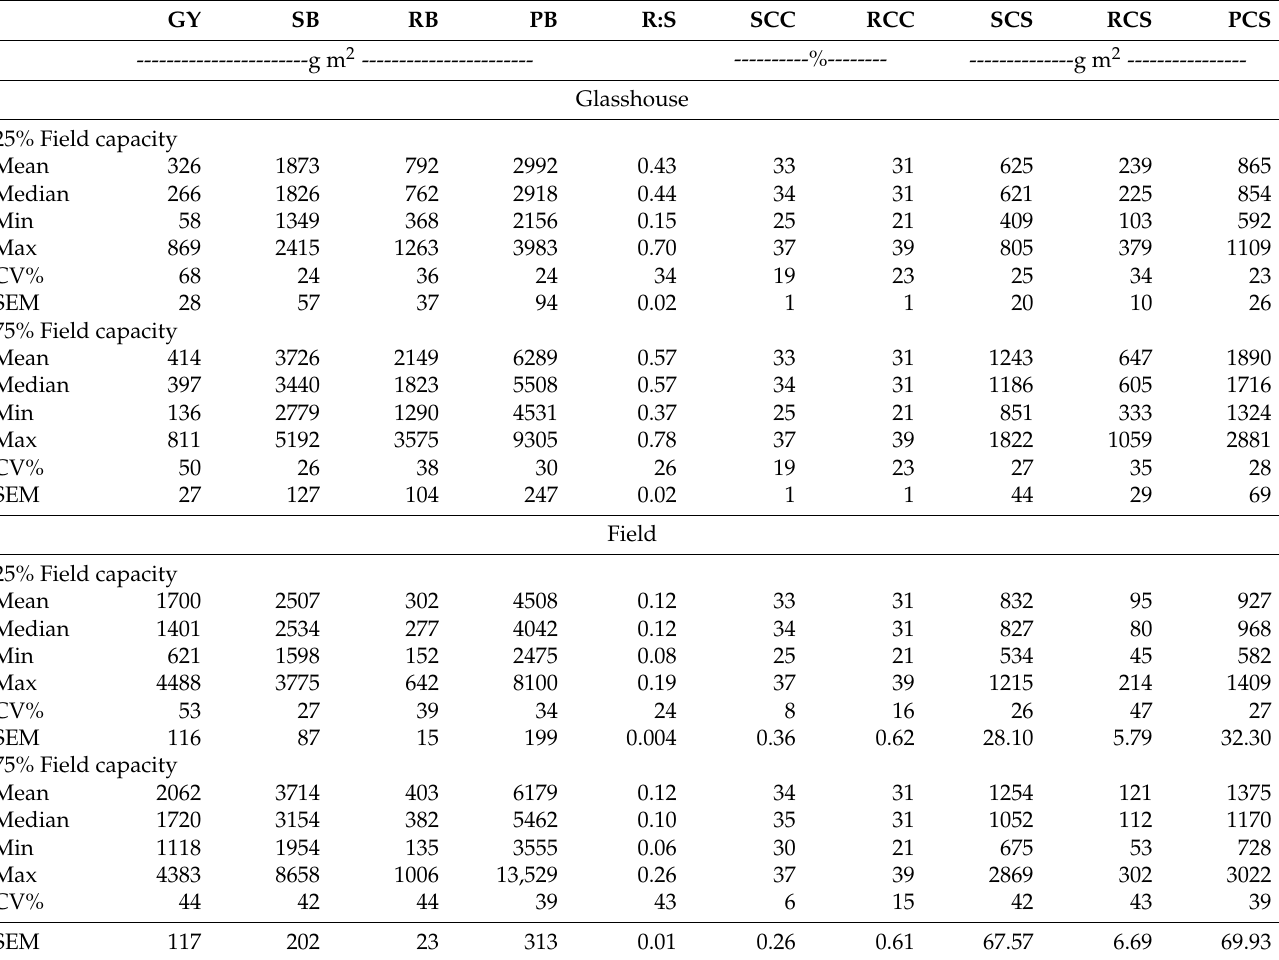
Table 3. Summary statistics (min = minimum: max = maximum; CV = coefficient of variation; SEM = standard mean error) for grain yield (GY), selected morphological variables (SB: shoot biomass, RB: root biomass, PB: total plant biomass, R:S: root to shoot), and plant carbon variables (SCC: